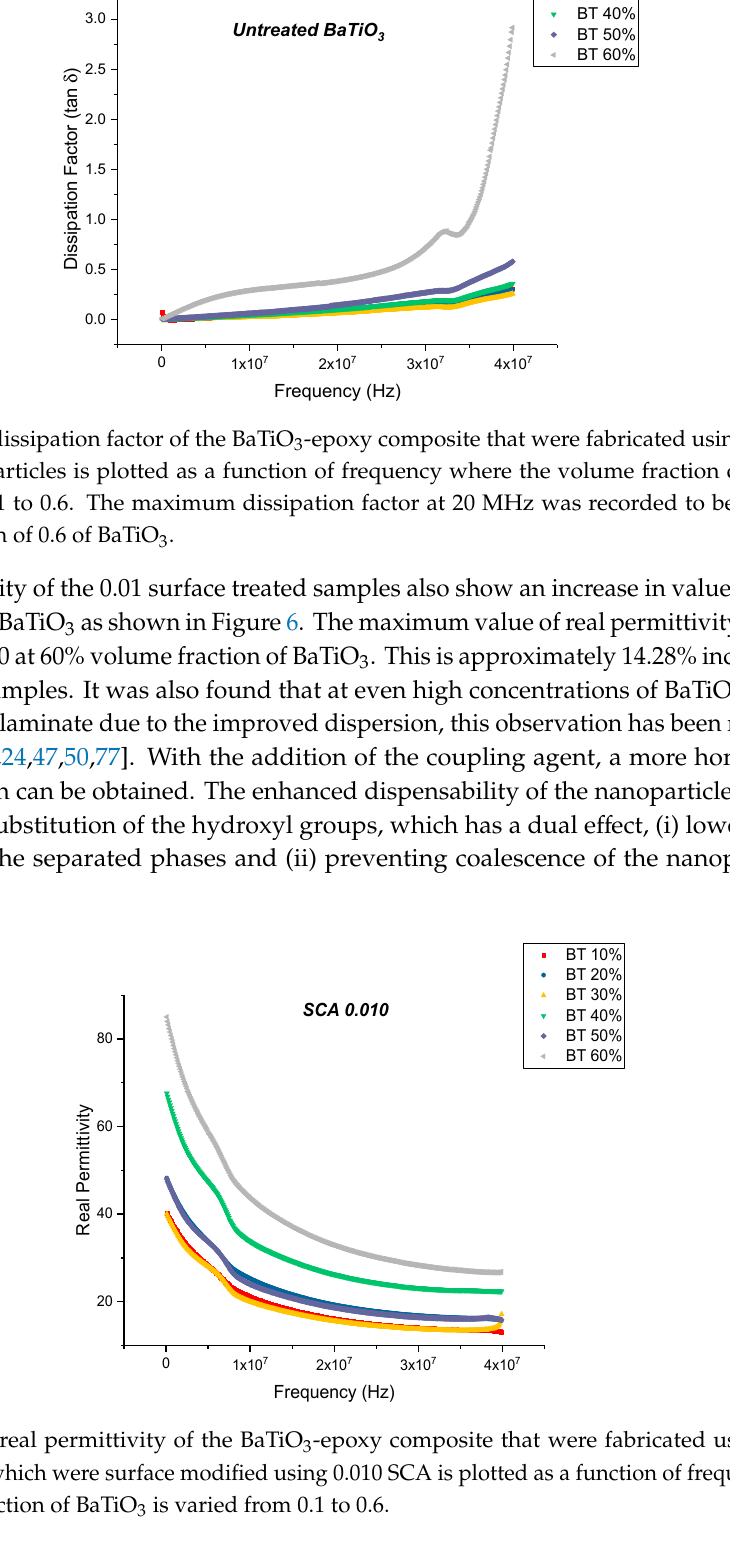
Figure 4. The dielectric loss of the BaTiO 3 -epoxy composite that were fabricated using untreated BaTiO 3 nanoparticles is plotted as a function of frequency where the volume fraction of BaTiO 3 is varied from 0.1 to 0.6. The maximum dielectric loss at 20 MHz was recorded to be 11.06 at a volume fraction of 0.6 of BaTiO 3.